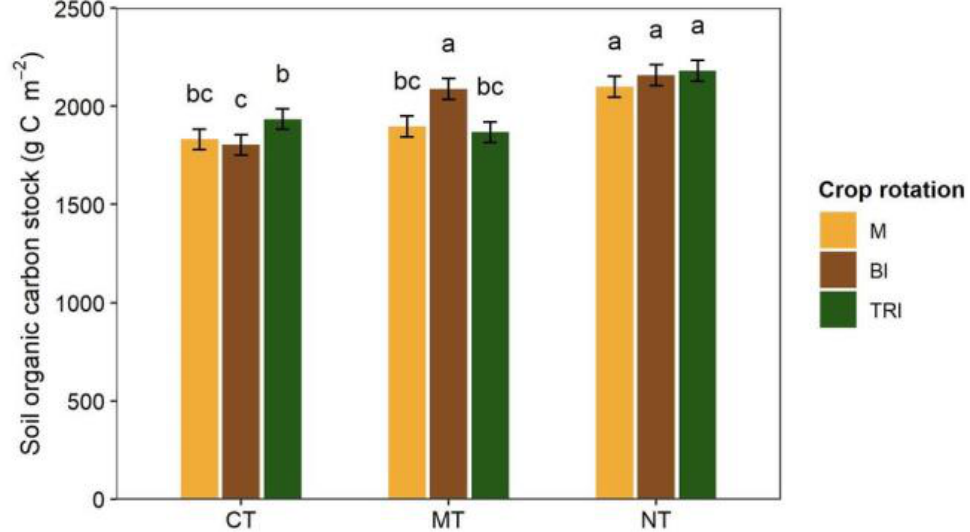
Figure 3. Effect of two-way interactions of ‘Tillage × Rotation’ on the soil organic carbon stock (SOCS, g C m − 2 ). Tillage effect (No till: NT, moderate tillage: MT, and conventional tillage: CT) and Rotation effect (Monocropping: M, biennial: BI, and triennial: TRI). Data are averages ± standard errors. Different lowercase letters indicate significant differences between treatments ( p < 0.05).